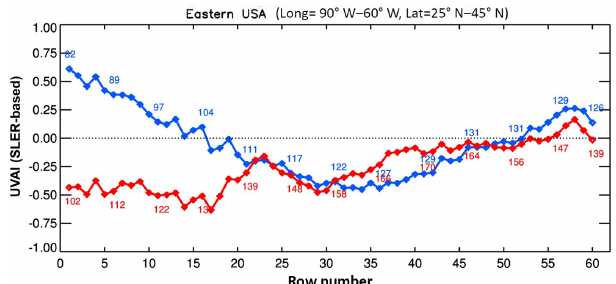
Figure 9. Monthly average values of retrieved LER-based UVAI as a function of viewing position (or row) number. Results for January (blue) and July (red) 2005 are shown. Numbers indicate the monthly average scattering angle for each